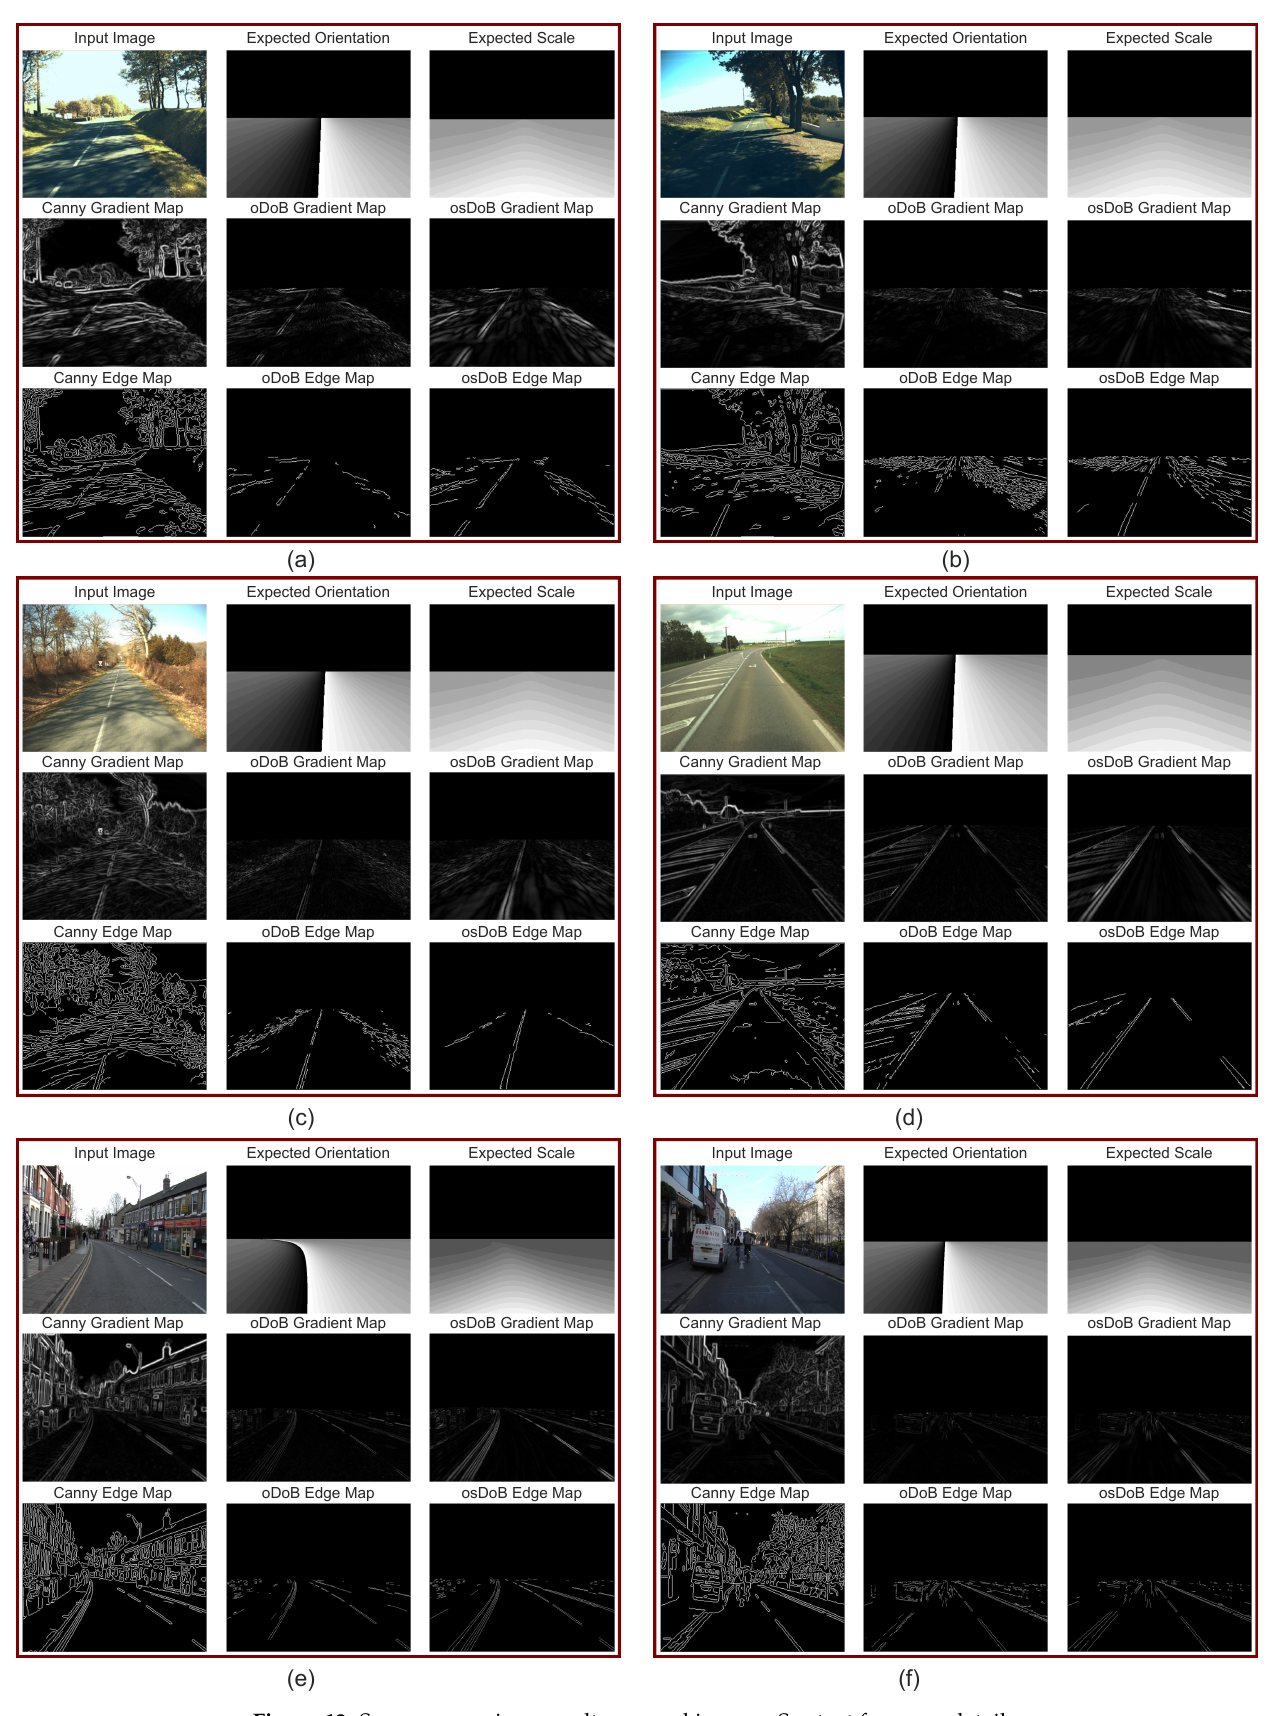
Figure 12. Some comparison results on road images. See text for more